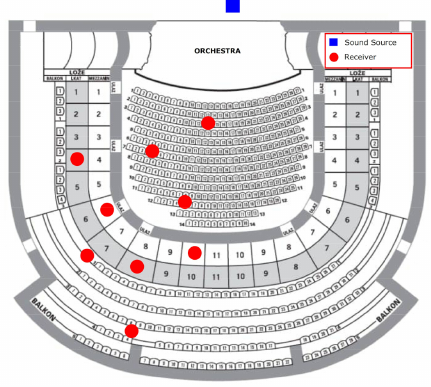
Figure 5. Scheme of the equipment location during the acoustic